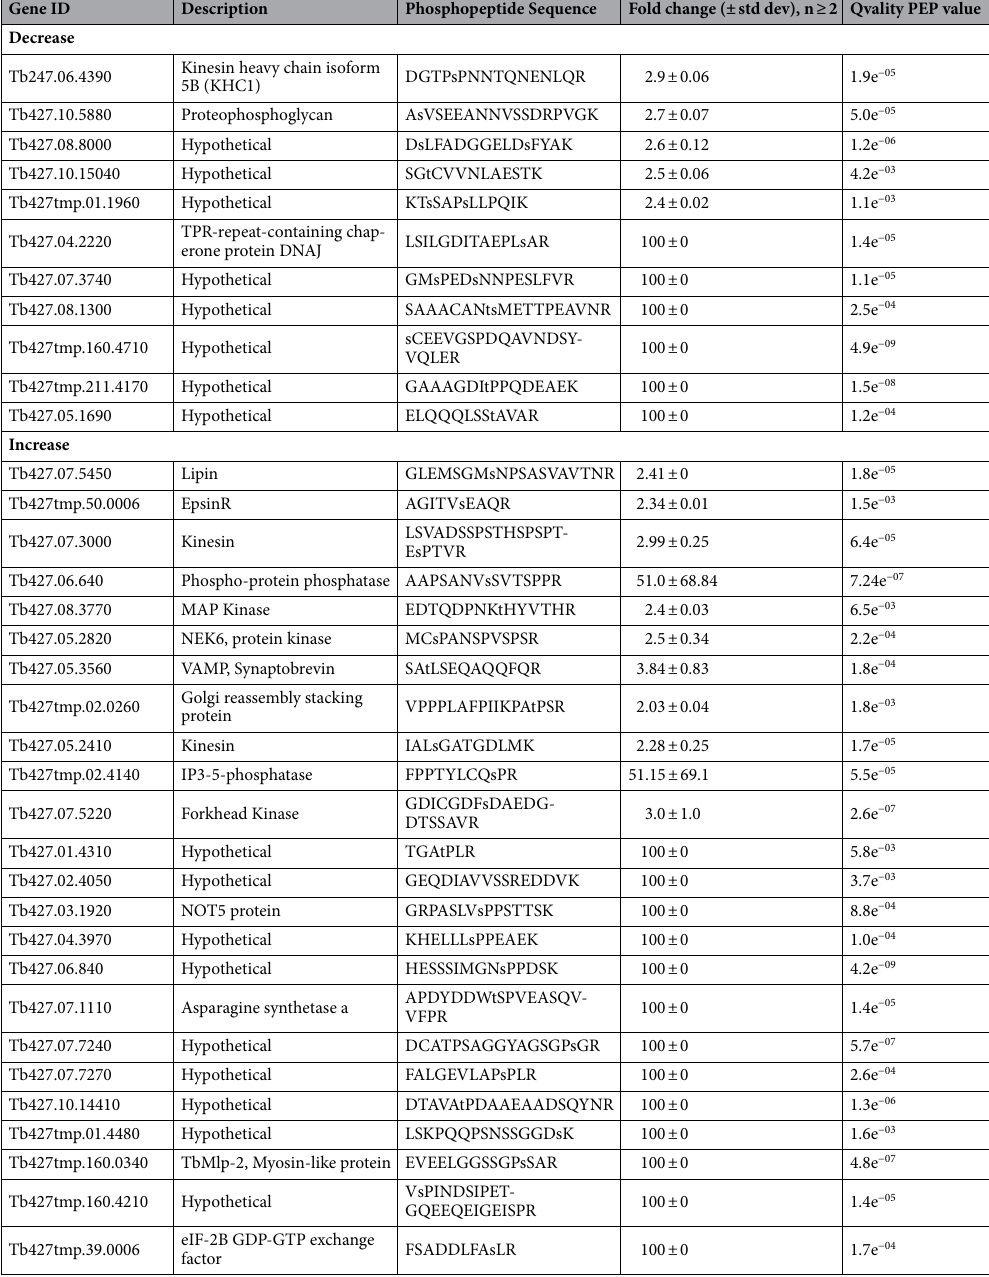
Table 1. Select TbNRP1-pathway proteins. Phospho-peptides whose abundance changed two-fold (at least) in two of more independent biological replicates in mass spectrometry experiment (see materials and methods) were presented, if their posterior error probability (Qvality PEP-value) was below 10 −3 . These phospho- peptides identify proteins affected after TbNRP1